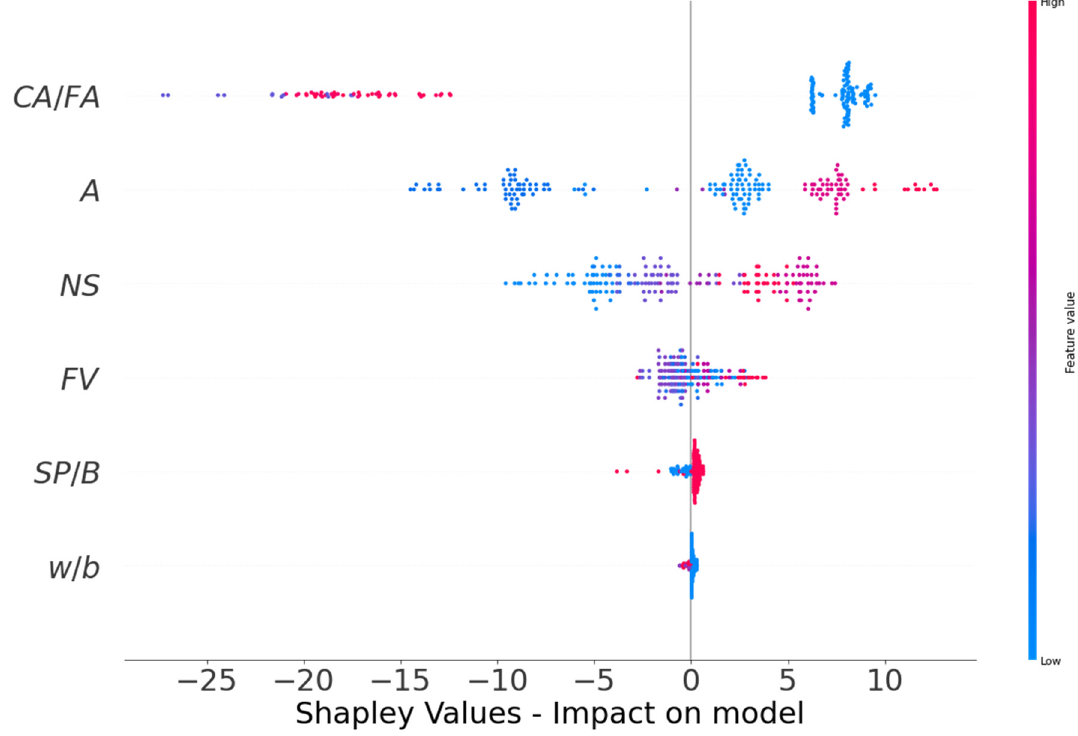
Figure 15. SHAP graph illustrating the impact of input features on ML models.